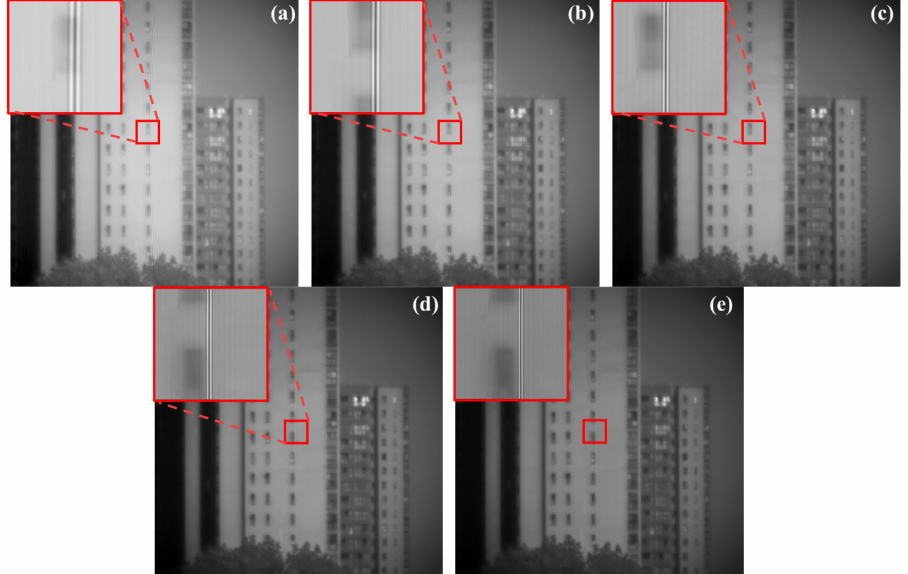
Figure 18. Captured interferograms ( a ) s = 0 mm, ( b ) s = 2.5 mm, ( c ) s = 5 mm, ( d ) s = 7.5 mm, ( e ) s = 10